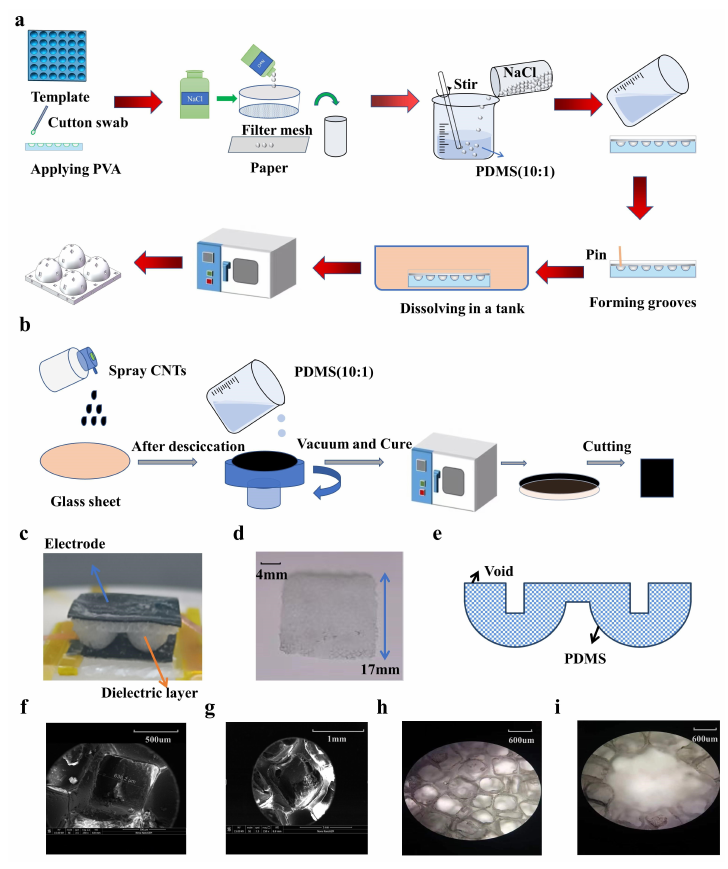
Figure 1. Overview of the capacitive pressure sensor based on a porous, hollow hemisphere dielectric layer (PHHDL). ( a ) Schematic diagram of the PHHDL fabrication process. ( b ) Schematic depiction of the electrode fabrication process. ( c ) The fabricated sensor and dielectric layer. ( d ) The obtained dielectric layer. ( e ) The sketch map of the cross-section of the dielectric layer. ( f – i ) Images of the dielectric